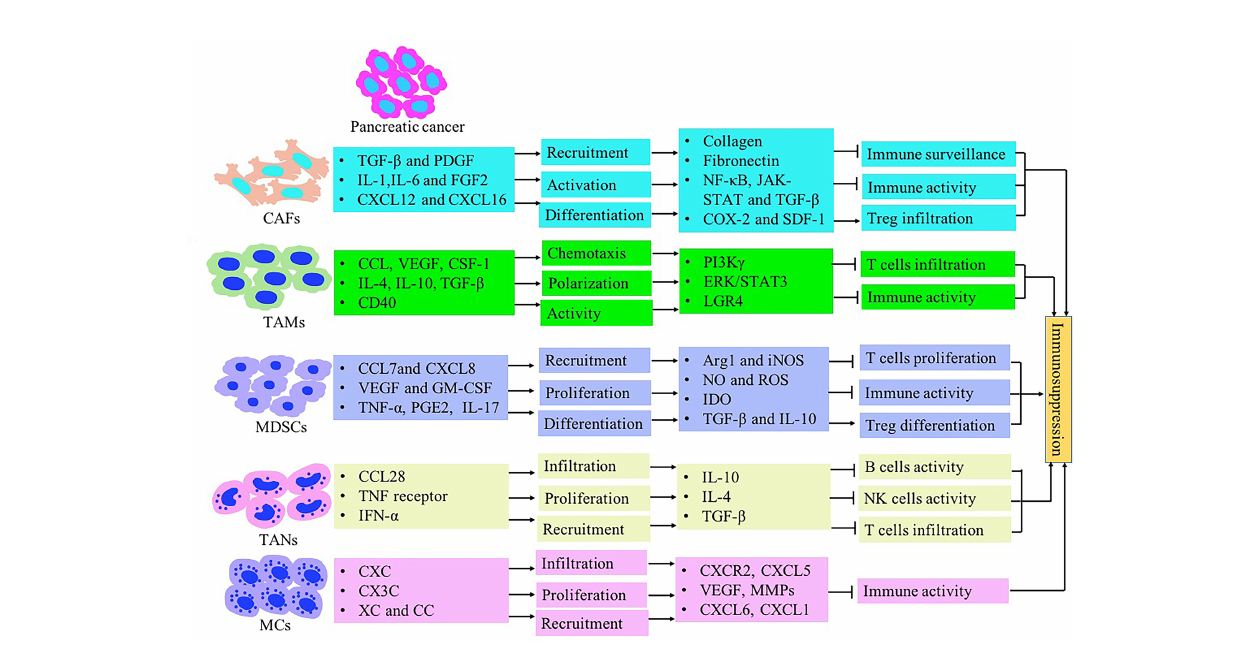
FIGURE 2 | The immunosuppressive tumor microenvironment in pancreatic cancer mediated by stromal cells such as CAFs, MDSCs, TAMs, TANs, Treg and MCs. In fl ammatory-associated factors secreted by pancreatic cancer induce stromal cells recruitment and expansion in the pancreatic TME. Stromal cells contribute to immunosuppression formation through inhibiting T lymphocyte activity and inducing Treg